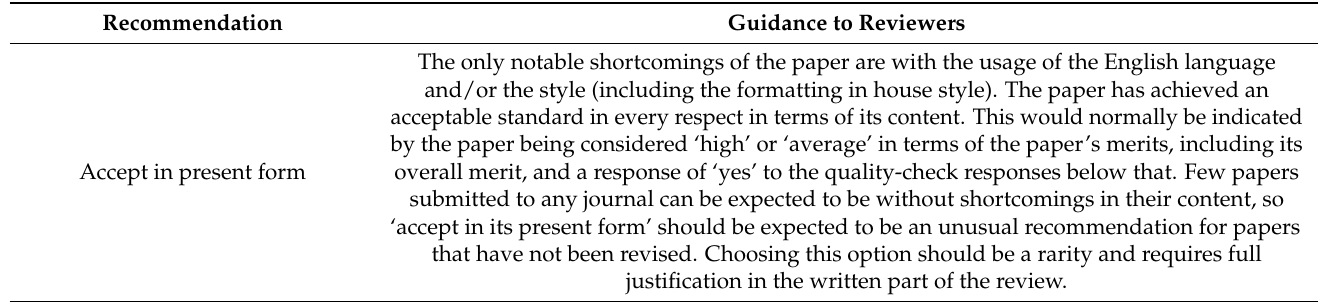
Table 2. Guidance on making overall